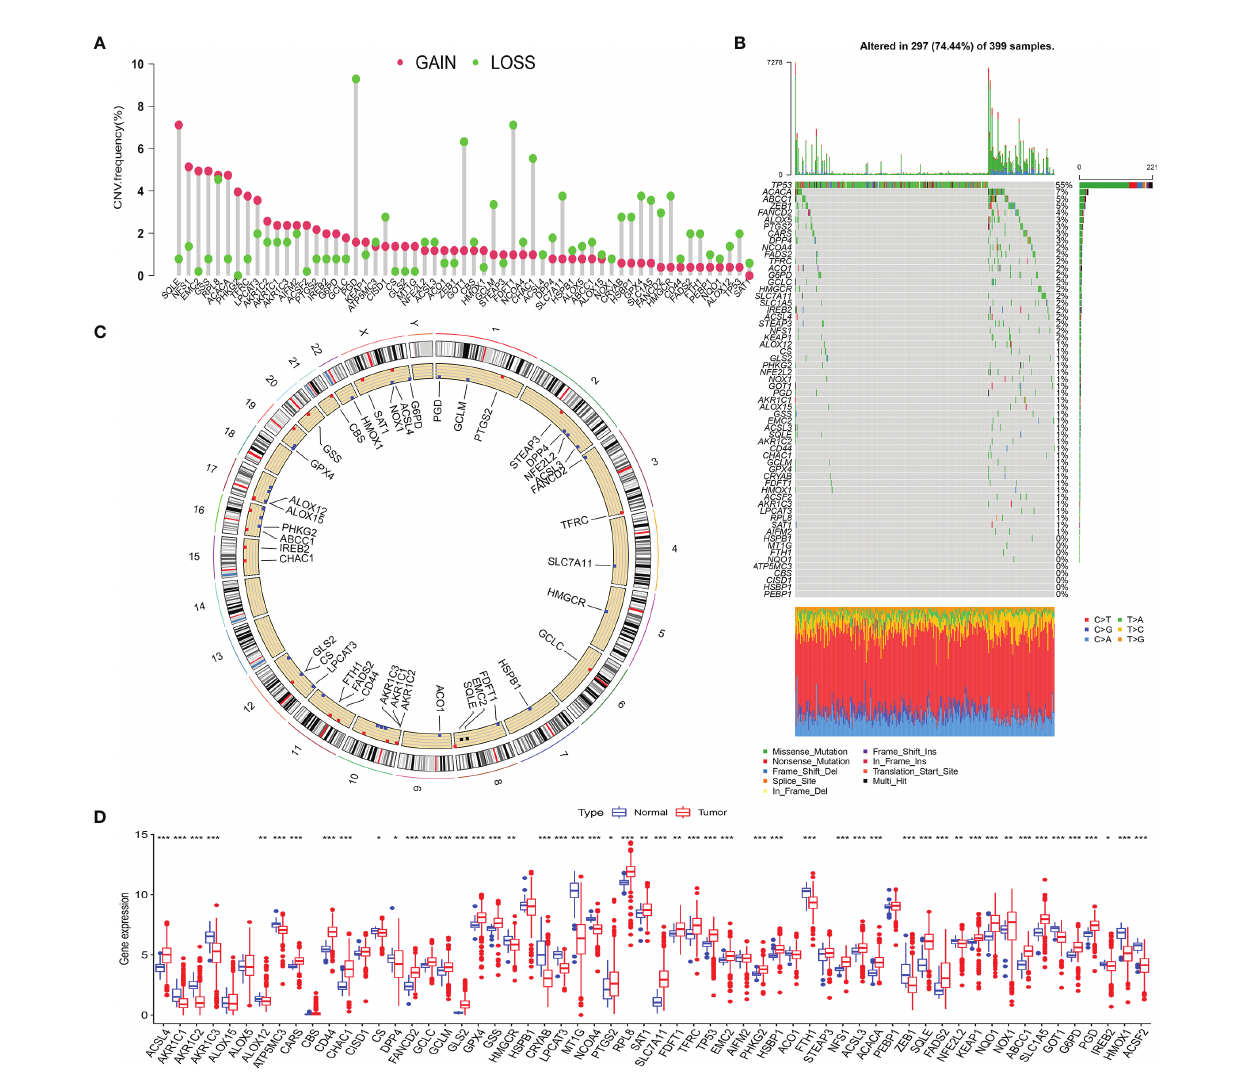
FIGURE 2 | (A) The CNV frequency of FRGs in TCGA cohort. The height of the column represents the alteration frequency. The green dot represents deletion frequency. The red dot represents ampli fi cation frequency. (B) The mutation frequency of 59 FRGs in 399 patients with LCC or RCC from TCGA-COAD cohort. The column represents the patients. The different colors below the fi gure represent the proportion of variant types. (C) The location of CNV alteration of FRGs on 23 chromosomes. (D) The difference of FRG expression in normal and tumor tissues. The statistical difference was compared by the Wilcoxon test (* p < 0.05, ** p < 0.01, *** p < 0.001). CNV, copy number variation; FRGs, ferroptosis-related genes; TCGA, The Cancer Genome Atlas; LCC, left-sided colon cancer; RCC, right-sided colon